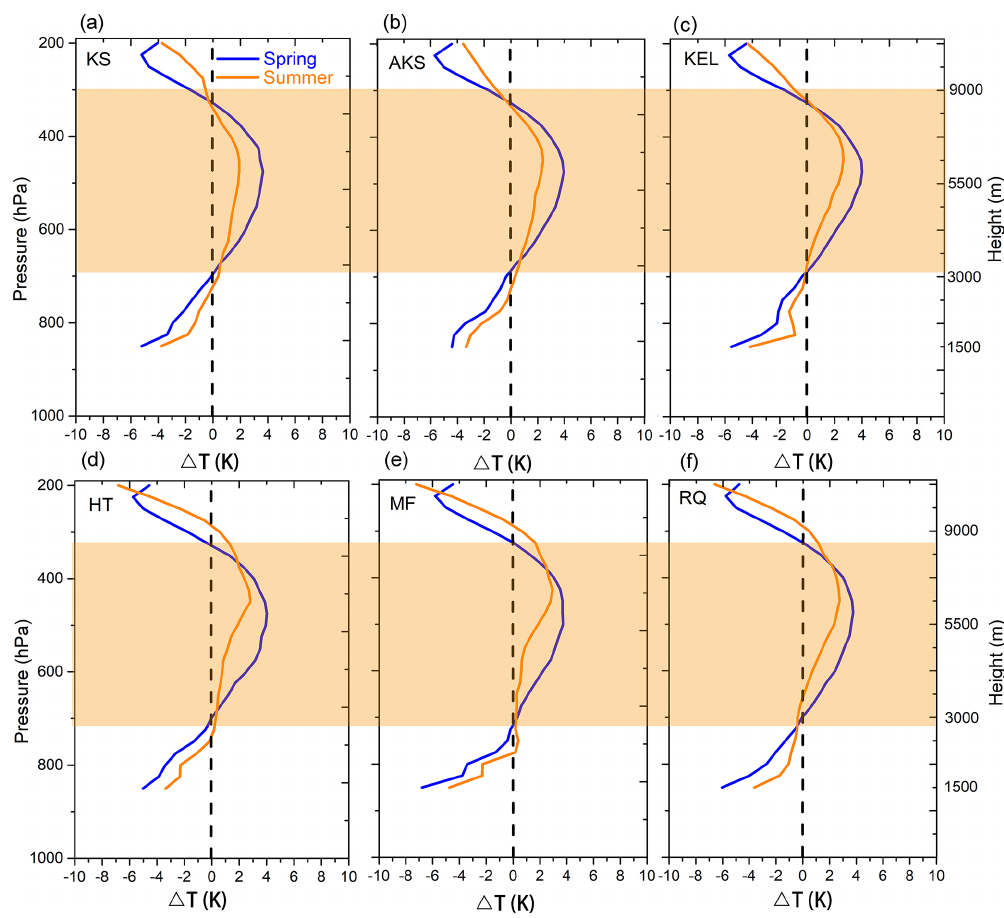
Figure 2. Temperature-difference ( (cid:49)T ) profiles in the spring and summer of 2016–2017 at the (a) Kashi (KS), (b) Akesu (AKS), (c) Kuerle (KEL), (d) Hetian (HT), (e) Minfeng (MF), and (f) Ruoqiang (RQ) radiosonde stations. Shadings indicate the layer with positive (cid:49)T